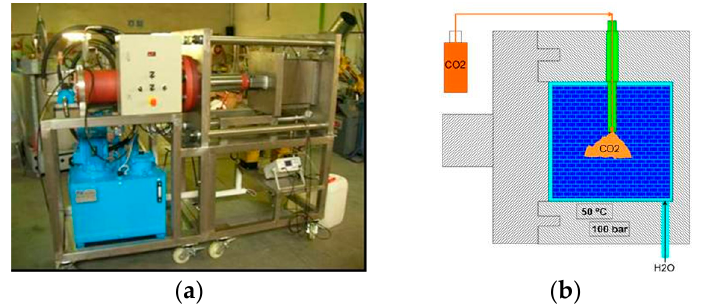
Figure 1. ( a ) Photogram and diagram of operation of test equipment named RockTestCO 2 ; ( b ) Description of what is contained in the second panel.